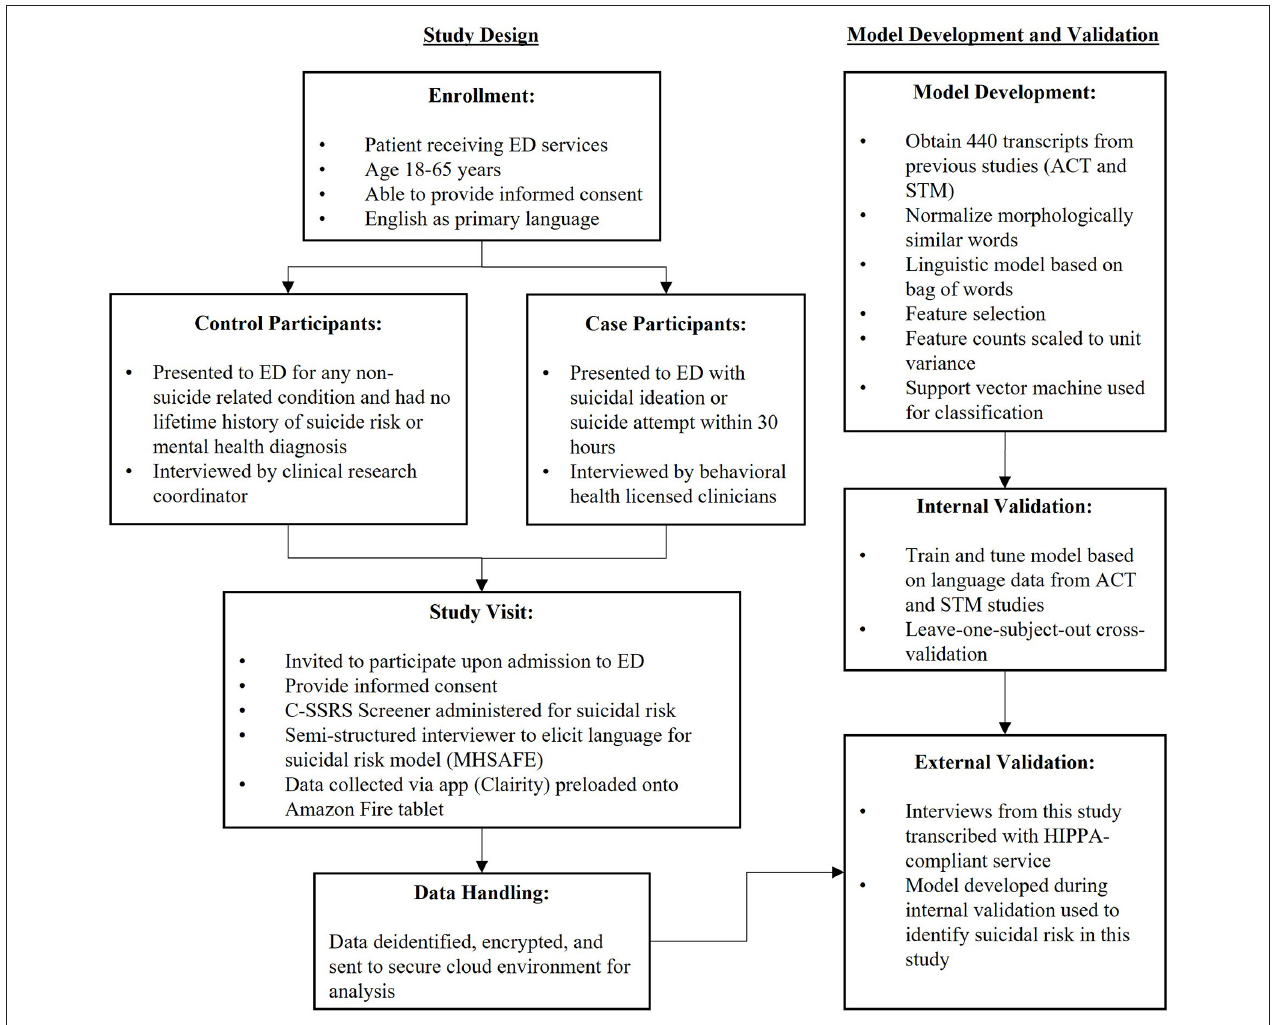
FIGURE 1 | Schematic of study and modeling